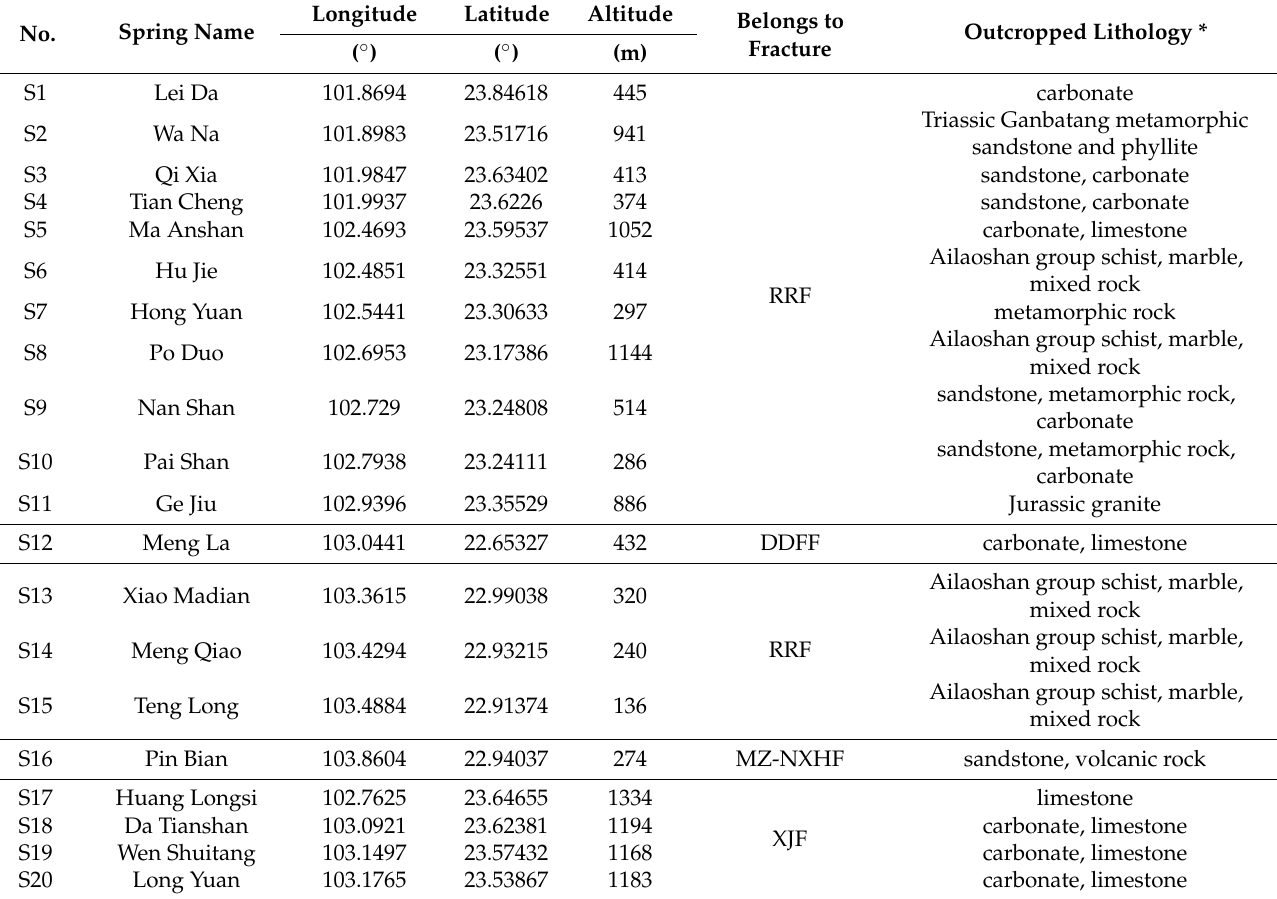
Table 1. The location and lithology of hot spring in the intersection area of the RRF and the